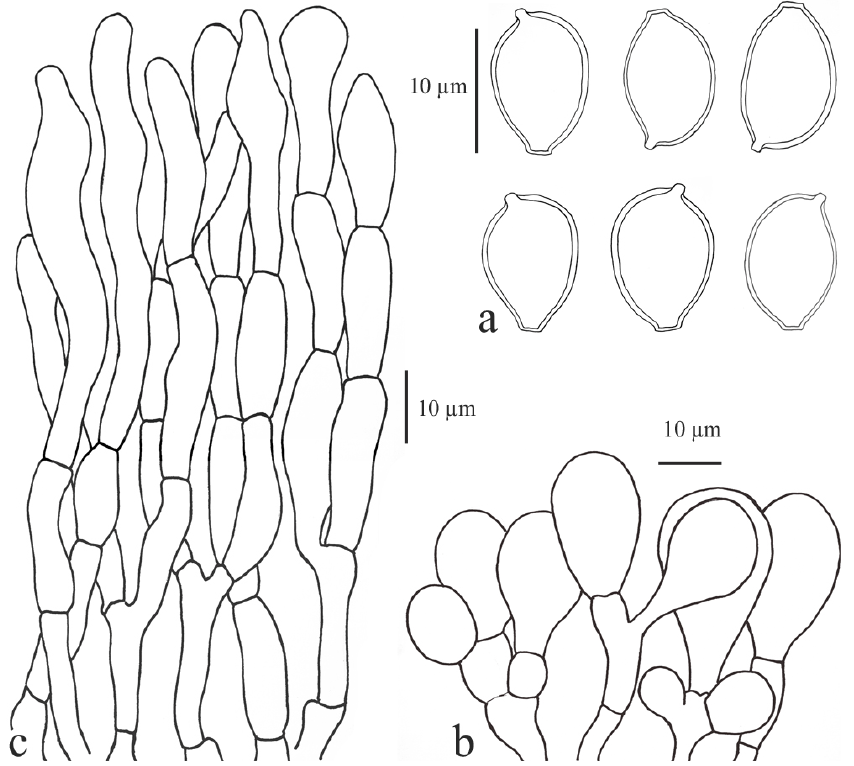
Figure 12. Microcharacters of Chlorophyllum molybdites (MFLU 12-1783). ( a ) basidiospores. ( b ) cheilocystidia. ( c ) pileus covering.